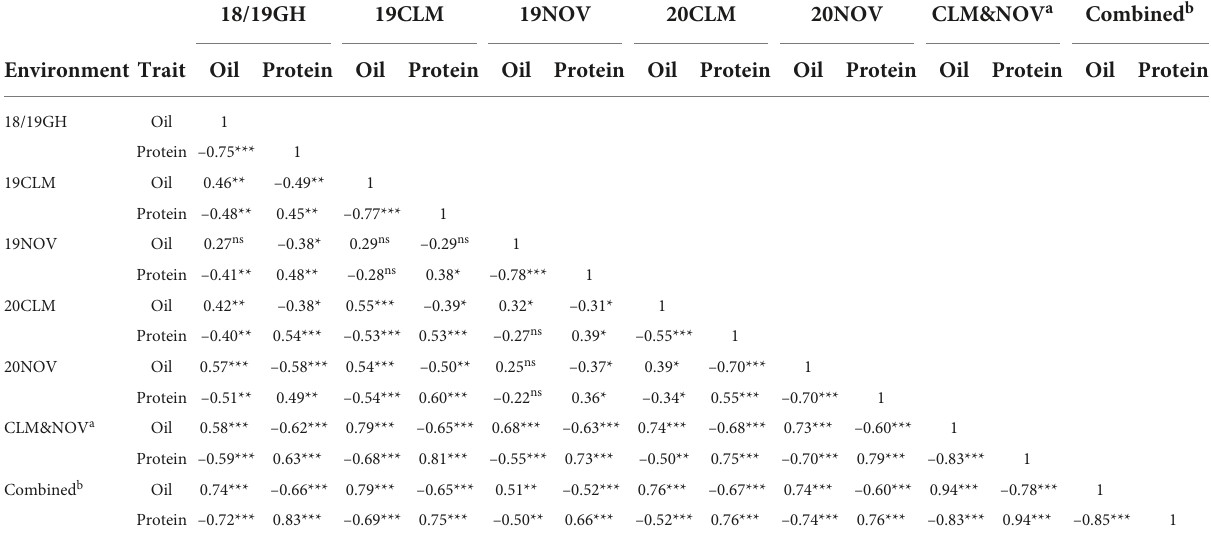
TABLE 4 Pearson correlation coefficient between seed oil and protein in the high protein RHD-NIL population across multiple environments.